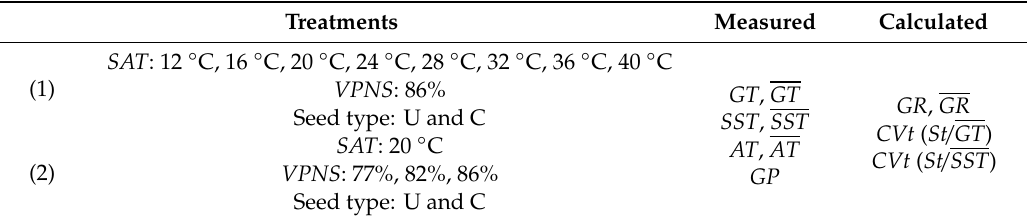
Table 2. Experimental design (see Table 1 for